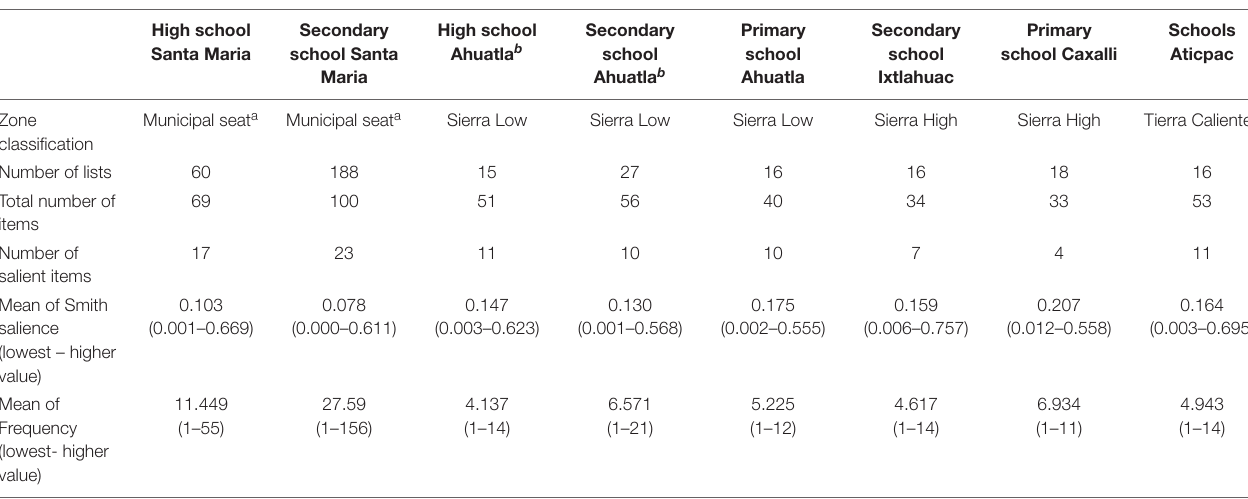
TABLE 3 | Number of lists and items for each school